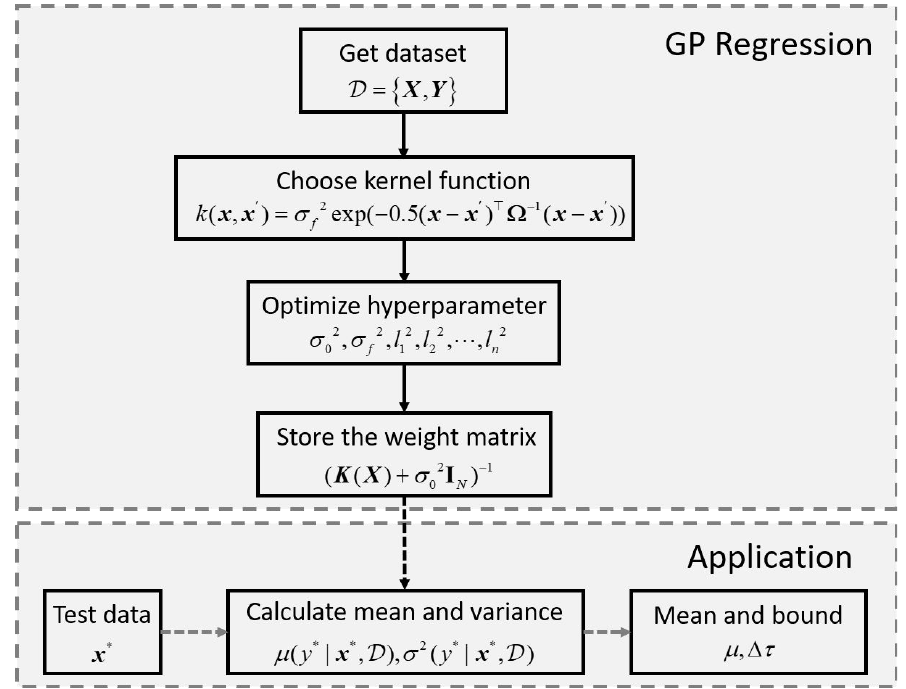
Figure 2. The flowchart of GP regression and its